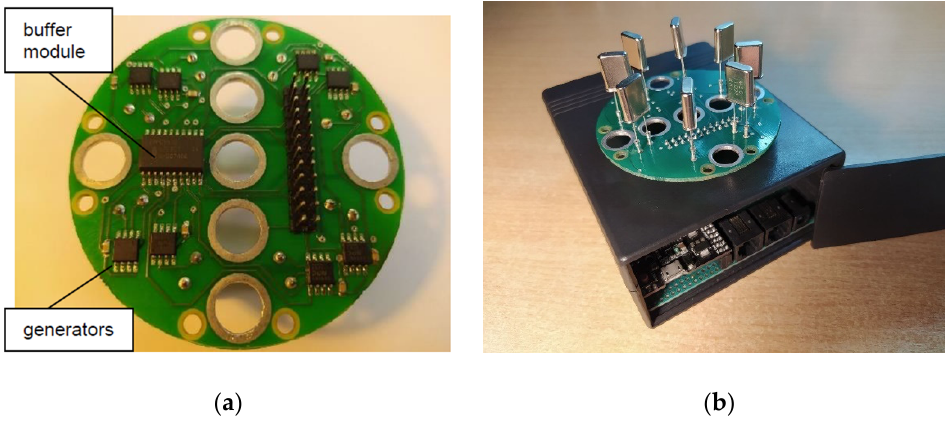
Figure 3. ( a ) Generators’ plate. ( b ) A measuring module in